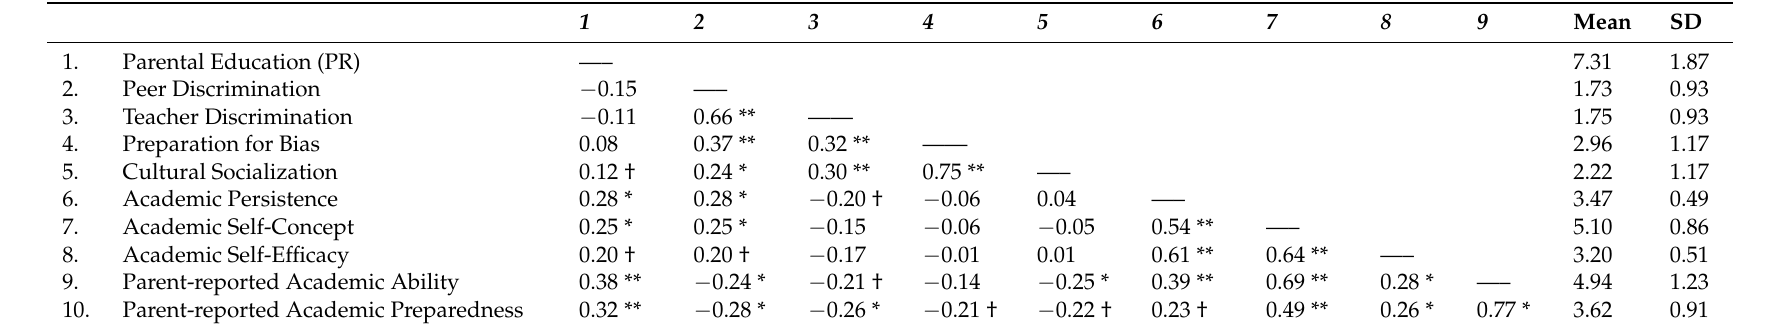
Table 1. Means, Standard Deviations, and Correlations of Study